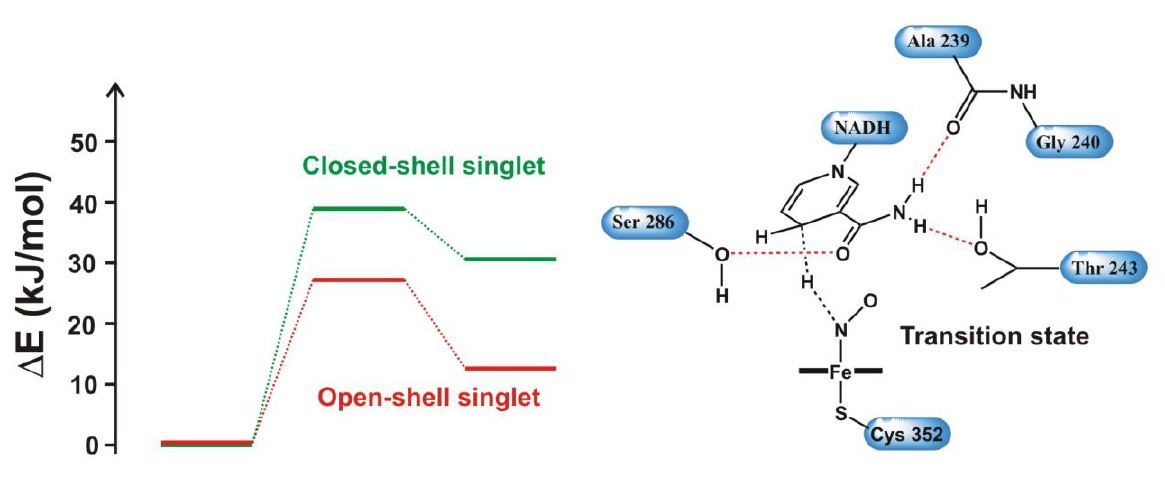
Figure 18. Energy profiles for closed-shell and open-shell singlet pathways for hydride transfer in the P450 and the schematic structure of the transition nor